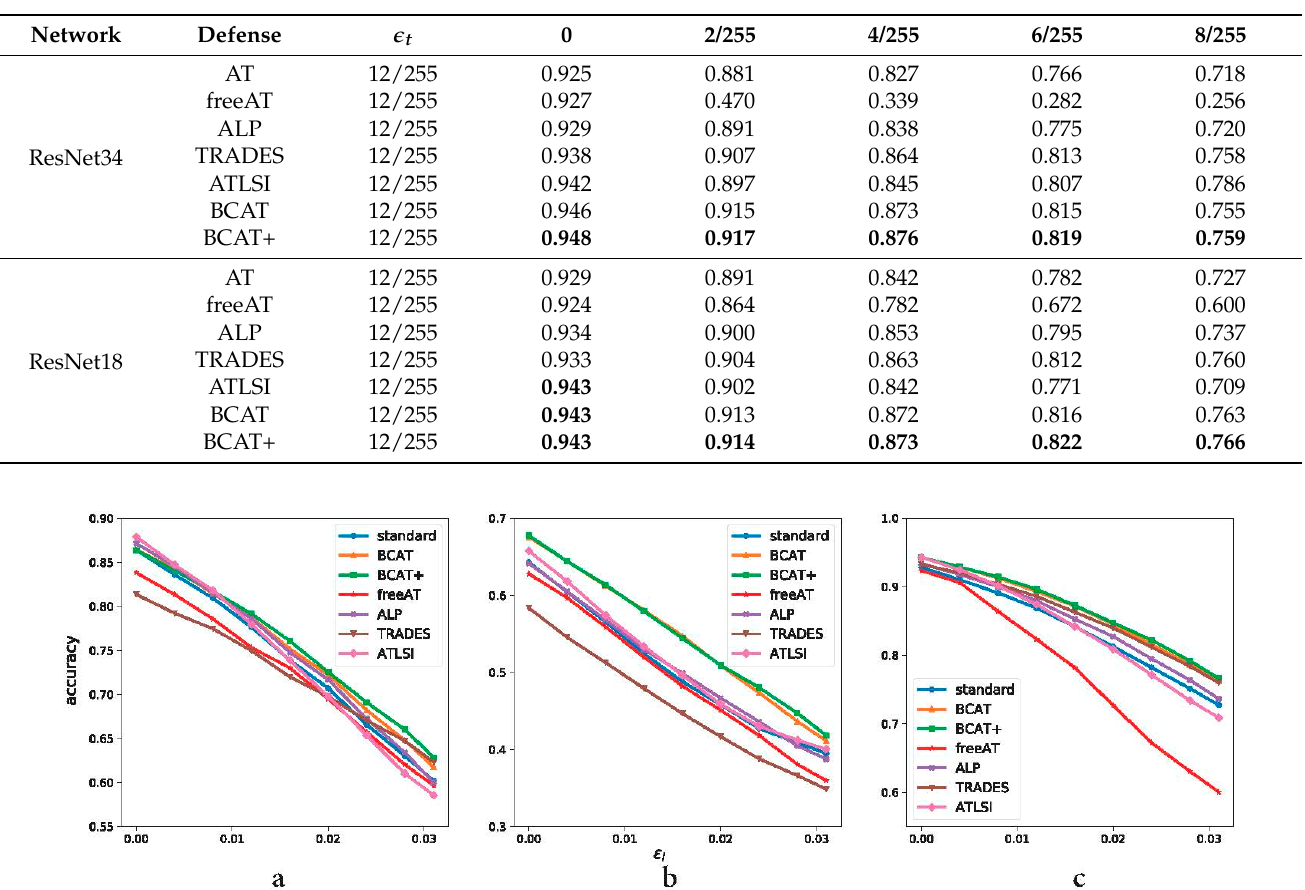
Table 3. Comparing the white-box adversarial robustness generalization accuracy of different defense methods on SVHN.